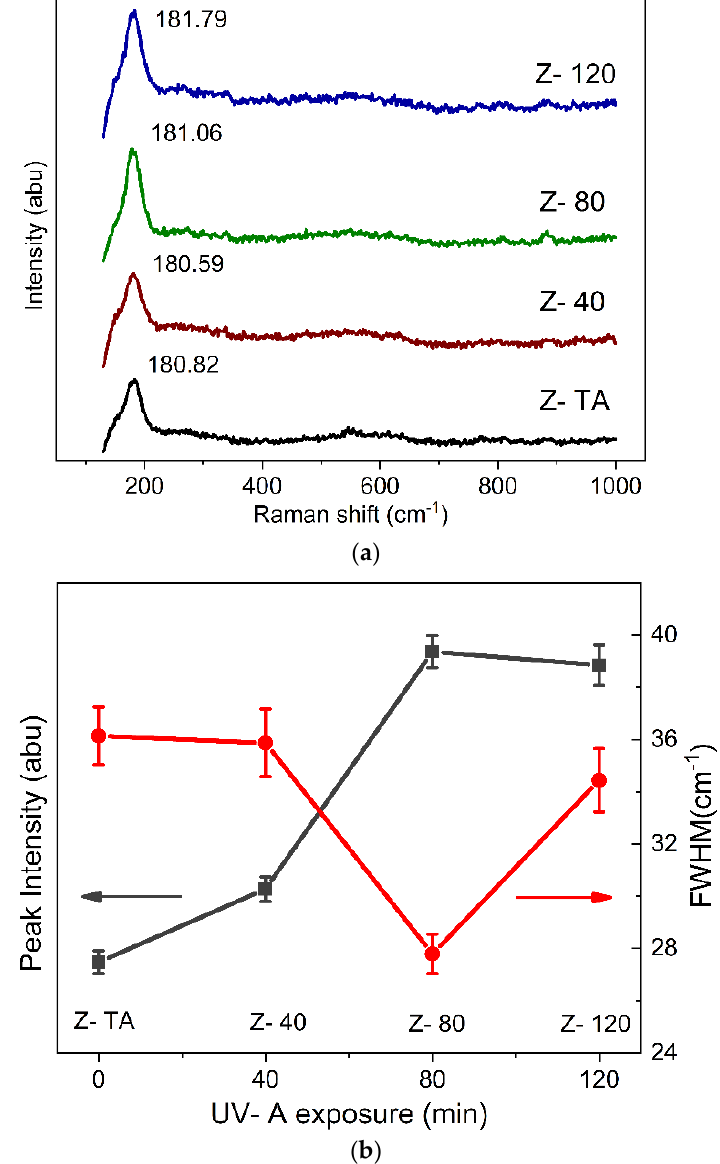
Figure 2. ( a ) Raman spectra are shown for thermally annealed and UV-A treated ZrO 2 films. The films appear amorphous as no characteristic phonon modes required to represent the crystalline phase are identifiable except for one mode around 180 cm − 1 that belongs to one of the 18 mode of monoclinic phase. Nonetheless, UV-A treatment has caused an improvement in this mode with prolonged exposure as depicted in ( b ) by the intensity and full width at half maximum (FWHM).